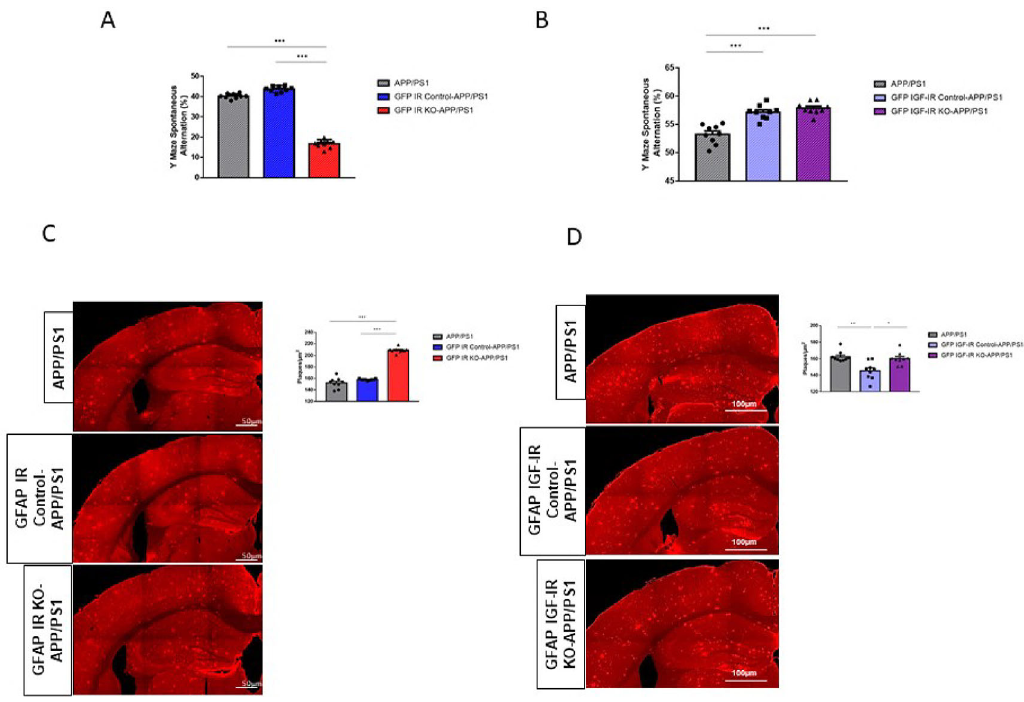
Figure 5. Modulation of Alzheimer ´ s-like pathology in GFAP IR KO/APP-PS1 and GFAP IGF-IR KO/APP-PS1 mice. A, Performance in the working memory version of the Y maze was impaired in GFAP IR KO APP/PS1 mice (n=8 per group; One-way ANOVA, F=73.23; ***p<0.001; Tukey ’ s Multiple comparison test, APP/PS1 vs. GFP IR KO-APP/PS1: ***p<0.001, GFP IR Control-APP/PS1 vs. GFP IR KO-APP/PS1: ***p<0.001). B, Working memory determined in the Y maze remained unaltered in GFAP IGF-IR KO APP/PS1 mice and controls (n=8 per group; One-way ANOVA, F=2.9; p=0.07). C, Amyloid plaques in the parietal cortex and hippocampus in GFAP IR KO/APP-PS1 mice and controls. Representative photomicrographs showing amyloid plaques (red). Histograms show number of plaques/ μ m 2 in three experimental groups (n=8 per group; One-way ANOVA, F=25.78; ***p<0.001; Tukey ’ s Multiple comparison test, APP/PS1 vs. GFP IR KO-APP/PS1: ***p<0.01, GFP IR Control-APP/PS1 vs. GFP IR KO-APP/PS1: ***p<0.001). D, Amyloid plaques in the parietal cortex and hippocampus in GFAP IGF-IR KO/APP-PS1 mice and controls does not show differences between groups. Representative photomicrographs showing amyloid plaques (red). Histograms show number of plaques/ μ m 2 in the three experimental groups (n=8 per group; One-way ANOVA, F=1.35; p=0.32). IR=insulin receptors, GFAP=glial fibrillary astrocytic